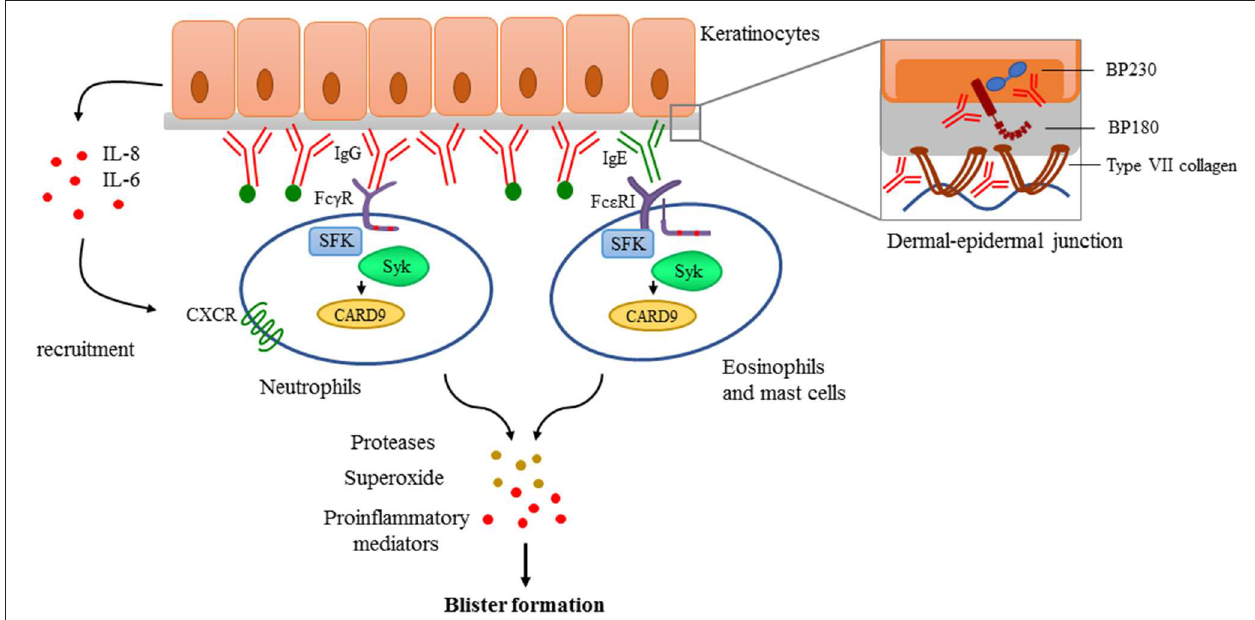
FIGURE 4 | Antibody-mediated signaling in pemphigoid diseases. Pemphigoid diseases are characterized by autoantibody production against components of the dermal-epidermal junction (DEJ) like BP180 and BP230 in case of bullous pemphigoid, or against type VII collagen in patients with epidermolysis bullosa acquisita (Structure of the DEJ with special attention to the above-mentioned autoantigens is shown on the upper right panel). Autoantibody deposition along the DEJ results in the activation of the complement system (indicated with green dots) and initiation of keratinocyte-responses involving IL-6 and IL-8 production. This leads to recruitment of innate effector cells like neutrophils, eosinophils, and mast cells. Recognition of deposited immune complexes through Fc receptors utilizing Src-family kinases (SFK), Syk, and CARD9 is critical for the development of pemphigoid diseases, as shown by genetic studies using transgenic animals (see more detail in the text). Immune complex-mediated activation of effectors leads to the release of reactive oxygen species, proteases, and the production of proinflammatory mediators culminating into blister